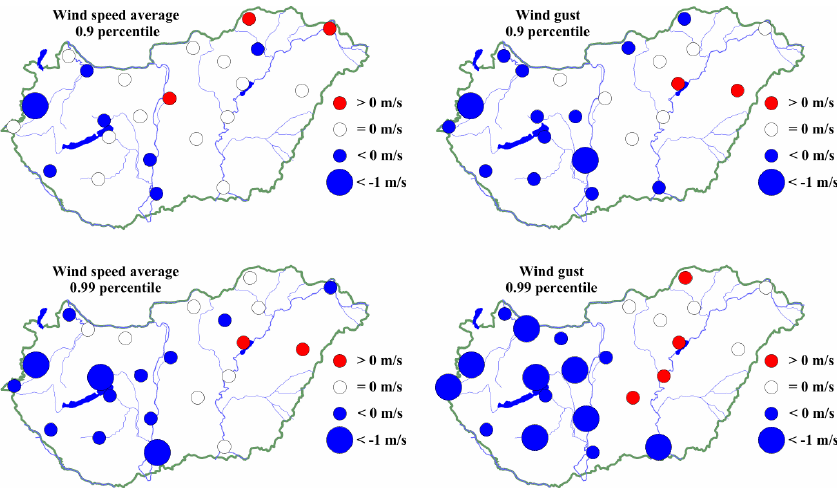
Figure 3. Spatial distribution of linear trend fitted on di ff erent percentile values (0.9 – up, 0.99 – down) calculated from three-year subseries Figure 3. of wind speed (left) and wind gust (right) values,